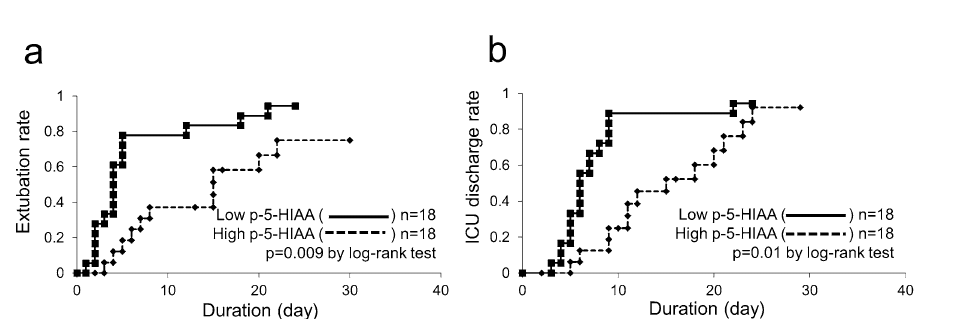
Figure 3. Longitudinal analysis of plasma 5-HIAA level and clinical outcome. The differences in the rate of mechanical ventilator extubation ( a ) and rate of ICU discharge ( b ) between the lower plasma 5-HIAA level group (≤ 13.6 ng/mL, n = 18) and higher-level group (> 13.6 ng/mL, n = 18). The results of the log-rank tests are